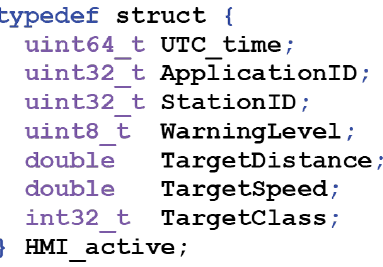
Figure 5. Structure